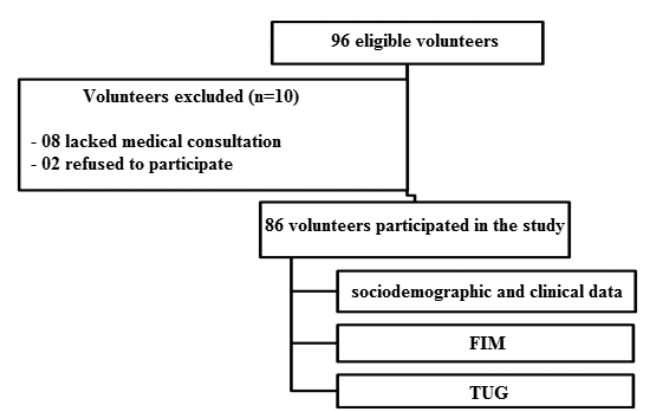
Figure 1: Flowchart of kidney transplanted patients in the study FIM: functional independencemeasure; TUG: Time Up and Go